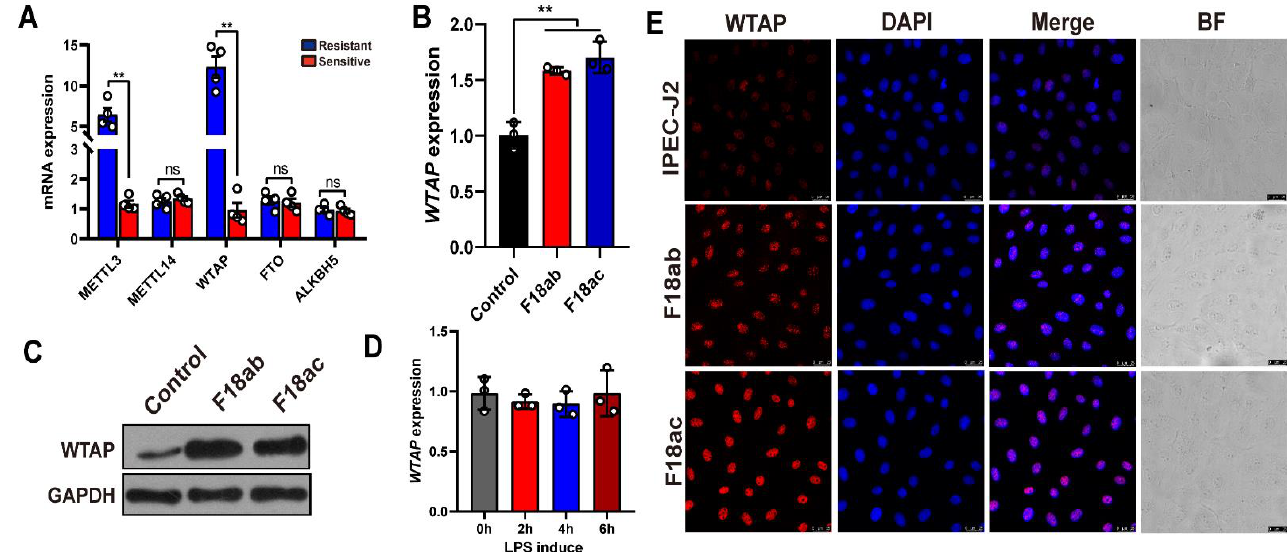
Figure 1. Expression analysis of m 6 A methyl markers in IPEC-J2 cells upon E. coli F18 exposure. ( A ) qPCR validation of METTL3, WTAP, METTL14, FTO, ALKBH5 expression in duodenum tissues between F18-resistant ( n = 4) and -sensitive piglets ( n = 4). ( B , C ) Expression changes of WTAP in F18ab/ac-stimulated IPEC-J2 cells by using qPCR and Western blotting analysis. ( D ) Expression changes of WTAP in LPS-induced IPEC-J2 cells. IPEC- J2 cells were treated with 0.1 μg/mL LPS for 0, 2, 4, and 6 h. ( E ) Immunofluorescence analysis of WTAP in IPEC-J2 upon E. coli F18ab/ac exposure. Scale bar, 25 μm. All data are presented as the mean ± SD, ns p > 0.05, ** p < 0.01.